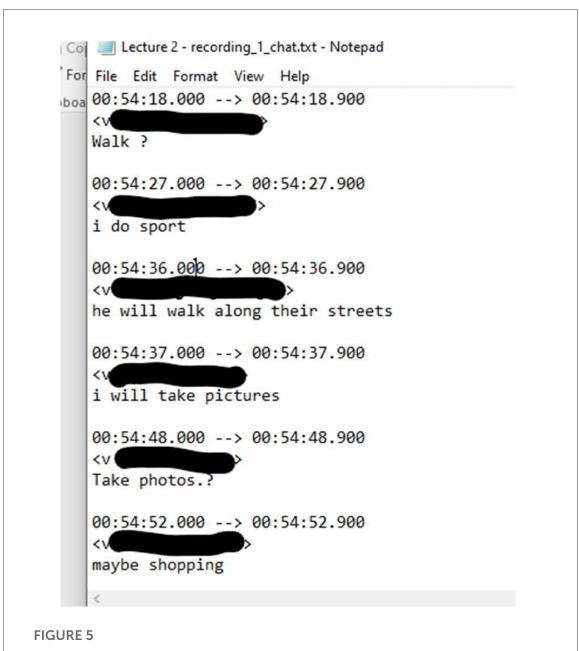
FIGURE5 Screenshot of text interaction in 142 Eng-2 virtual classroom.